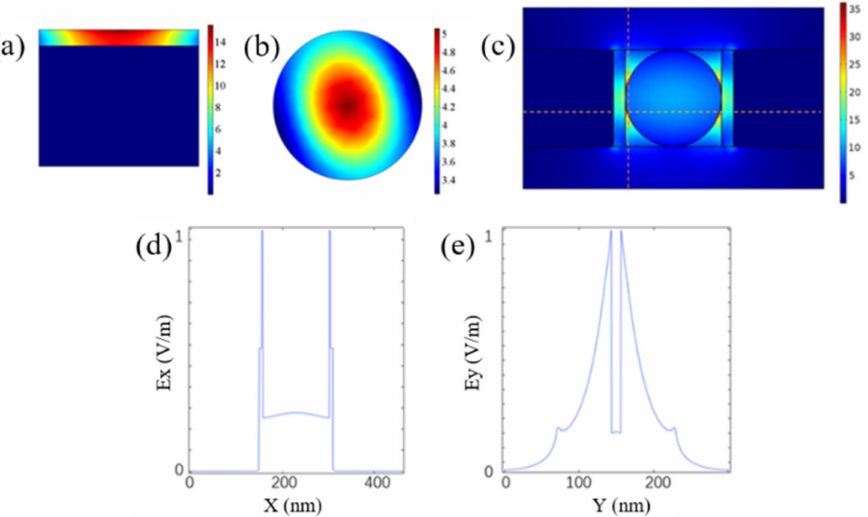
Figure 2. Electric field distributions of ( a ) SP mode, ( b ) nanowire waveguide mode, and ( c ) HPW mode. Normalized field intensities of ( d ) horizontal transverse and ( e ) longitudinal transverse